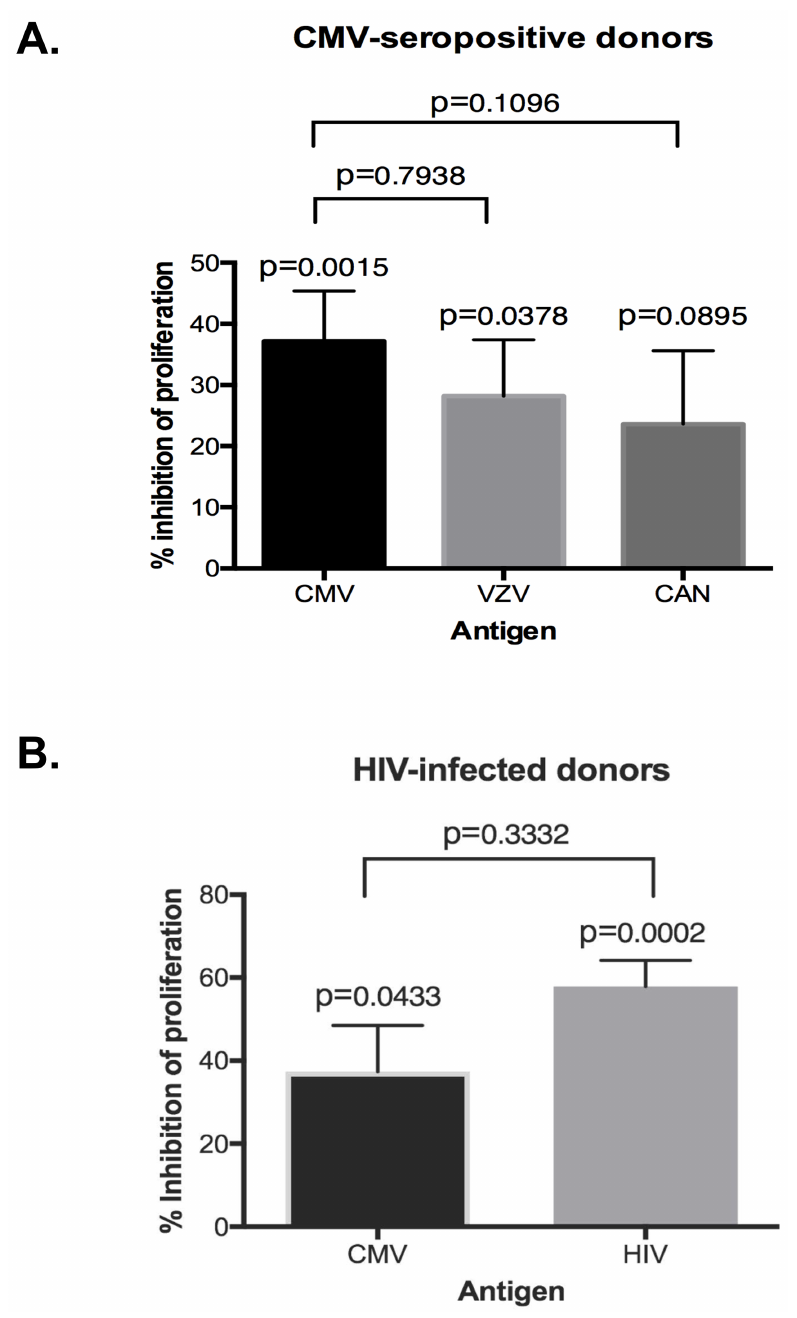
Fig 5. Breadth of inhibitory activity of peripheral blood CD4+CD27-CD28- Treg from CMV-seropositive donors. Panel A shows a comparisonof CMV-), VZV- and candida-specific proliferation inhibitionusing sorted peripheralblood CD4+CD27-CD28-Treg and autologousPBMC from 5 to 10 donors/antigen at effector to target ratios = 1:3. Panel B shows inhibitionof proliferation of PBMC from 6 HIV-pos CMV-pos donorsstimulatedwith CMV or HIV by autologous peripheral blood CD3+CD27-CD28- Treg at an effector to target ratio = 1:3. Inhibition of proliferation was calculatedby the followingformula: [(medianCPM of antigen- stimulatedwells) -(medianCPM of antigen-stimulated+ Treg wells)]/(median CPM of antigen-stimulated wells) x 100. P values aboveeach column were calculatedby single sample T test comparedwith 0% inhibition.P values betweencolumns were calculatedby unpairedT test. S3 Fig shows the same data presented in absolute CPM.